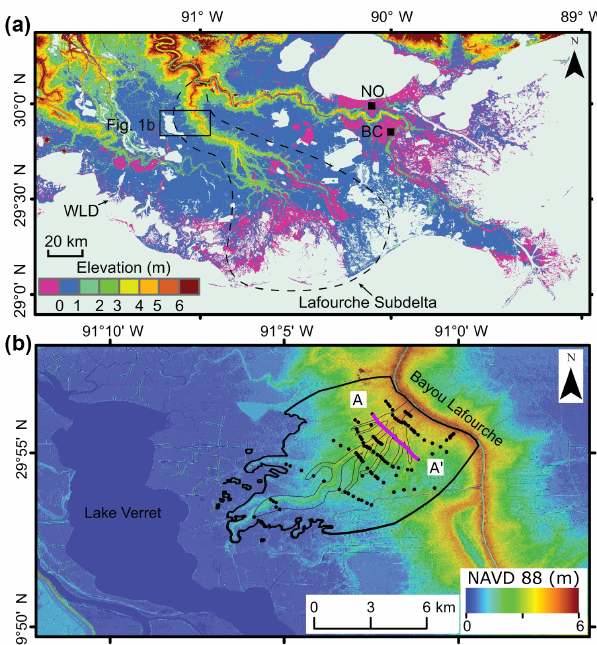
Figure 1. Digital elevation models (DEMs) of the study area. (a) Mississippi Delta, Louisiana, USA. Regional data are derived from the 1 / 3arcsec DEM of the US Geological Survey (http: //viewer.nationalmap.gov/basic/#startUp), accessed in September 2015. (b) The Attakapas Crevasse Splay at Napoleonville, Louisiana. Black dots mark core locations. The surface expression of the silty splay deposit used in the 3-D model is marked by the thick black line. Thin black lines show alluvial ridges associated with splay channels. The local DEM is derived from light detec- tion and ranging data available from Atlas: The Louisiana State GIS (http://atlas.lsu.edu). NO – New Orleans; BC – Belle Chasse; WLD – Wax Lake delta; NAVD 88 – North American Vertical Datum of